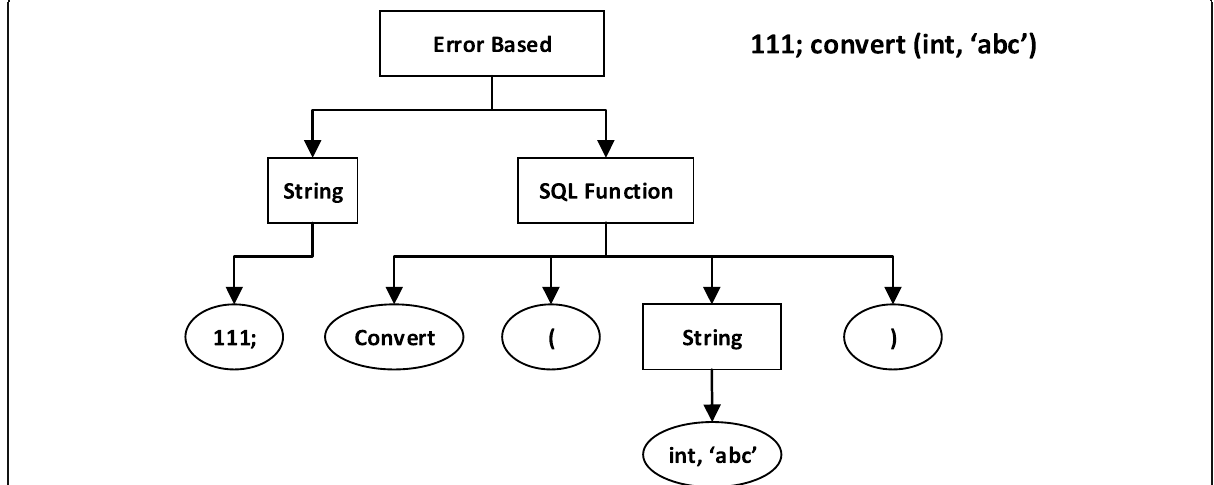
Fig. 3 Parse tree to depict error-based SQL injection attacks. (ii). Batch query SQL injection attacks